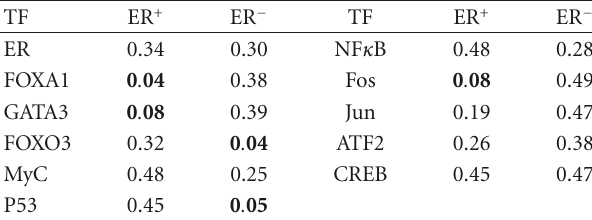
Table 2: Significance level of the logrank